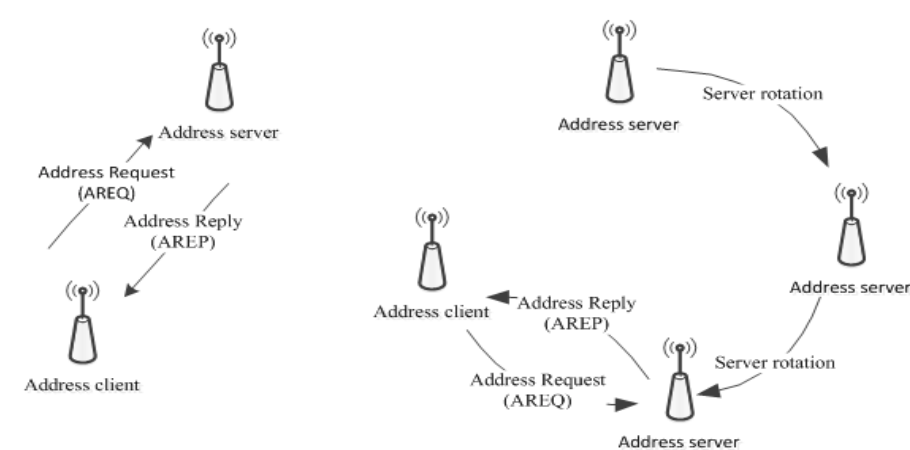
Figure 8. An addressing scheme and server rotation scheme (adapted from [15]).